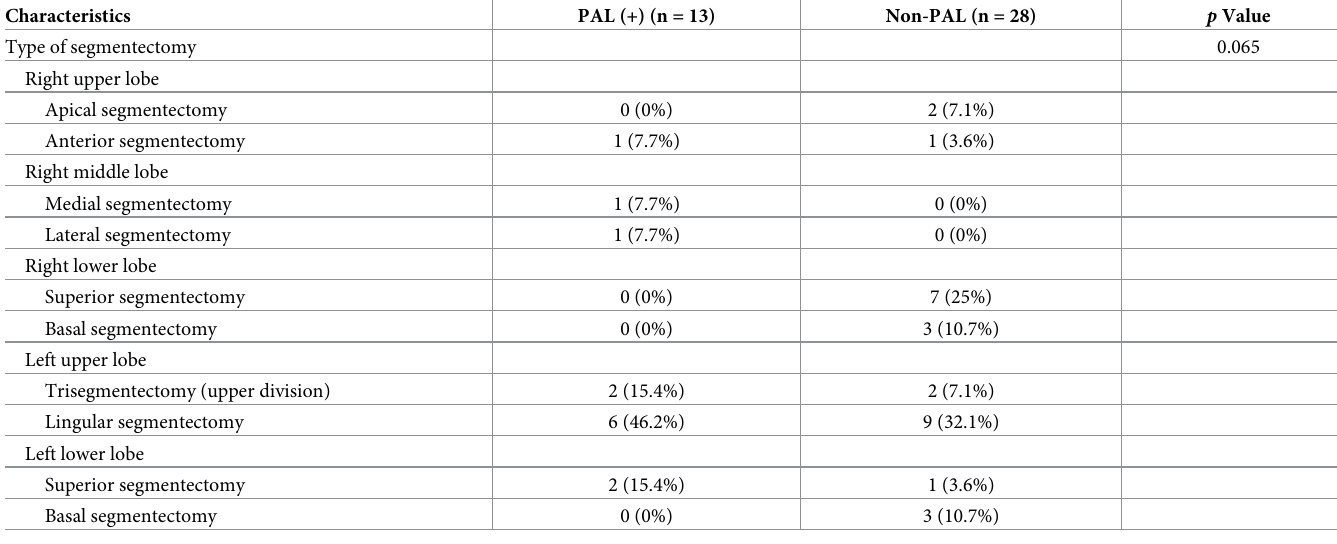
Table 2. Comparison of types of